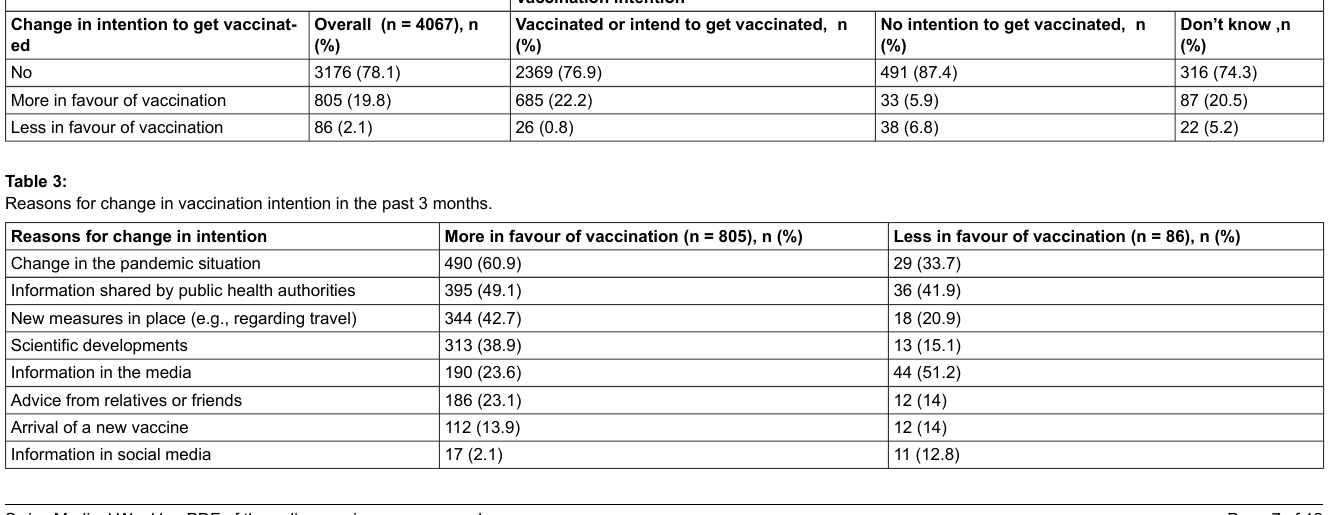
Vaccination intention